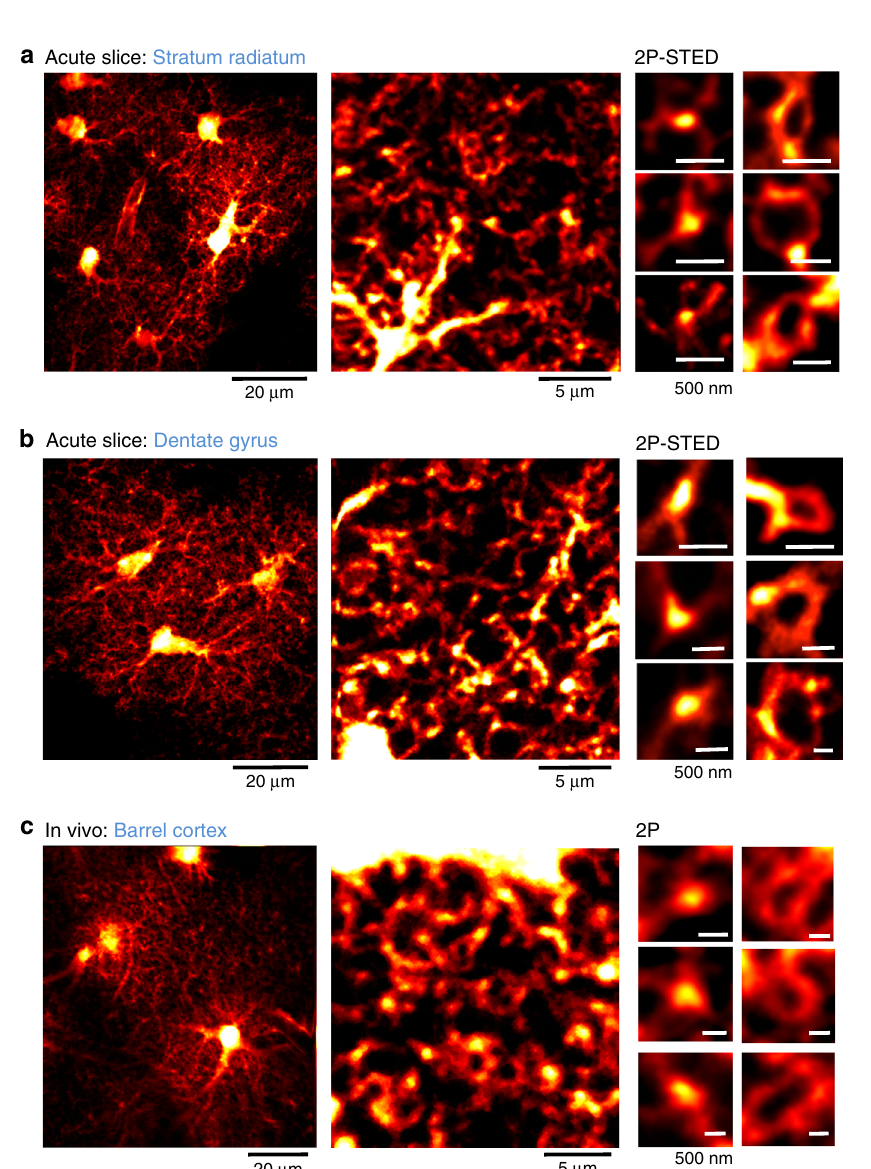
Fig. 1 Spongiform domain is formed by meshwork of nodes and shafts, and features loops. a Confocal overview image of astrocytes expressing ZsGreen. b Z-stack STED images of spongiform domain showing an elaborate reticular meshwork. c Loop-like structures observed in the spongiform domain. d Orthogonal views of a loop-like structure. e 3D view of the loop-like structure shown in d . f Frequency distribution of loop inner perimeter ( n = 297 from 4 slices). g Frequency distribution of loop inner area ( n = 297 from 4 slices). h Nodes at branch points (branched) and along the shaft (en passant) (left) and the percentage of respective structures (right). Nodes frequently form branch points ( n = 261 nodes from 14 slices). i Frequency distribution of node width ( n = 109 nodes from 14 slices). j Frequency distribution of shaft length connecting two neighbor nodes. Nodes were closely spaced ( n = 174 shafts from 11 slices). k Distribution of shaft width. Shaft width was frequently below the diffraction limit of conventional light microscopy (<200 nm; gray box), making the use of super-resolution approach necessary ( n = 94 shafts from 14 slices). (See also Supplementary Figs. 1 and 2).